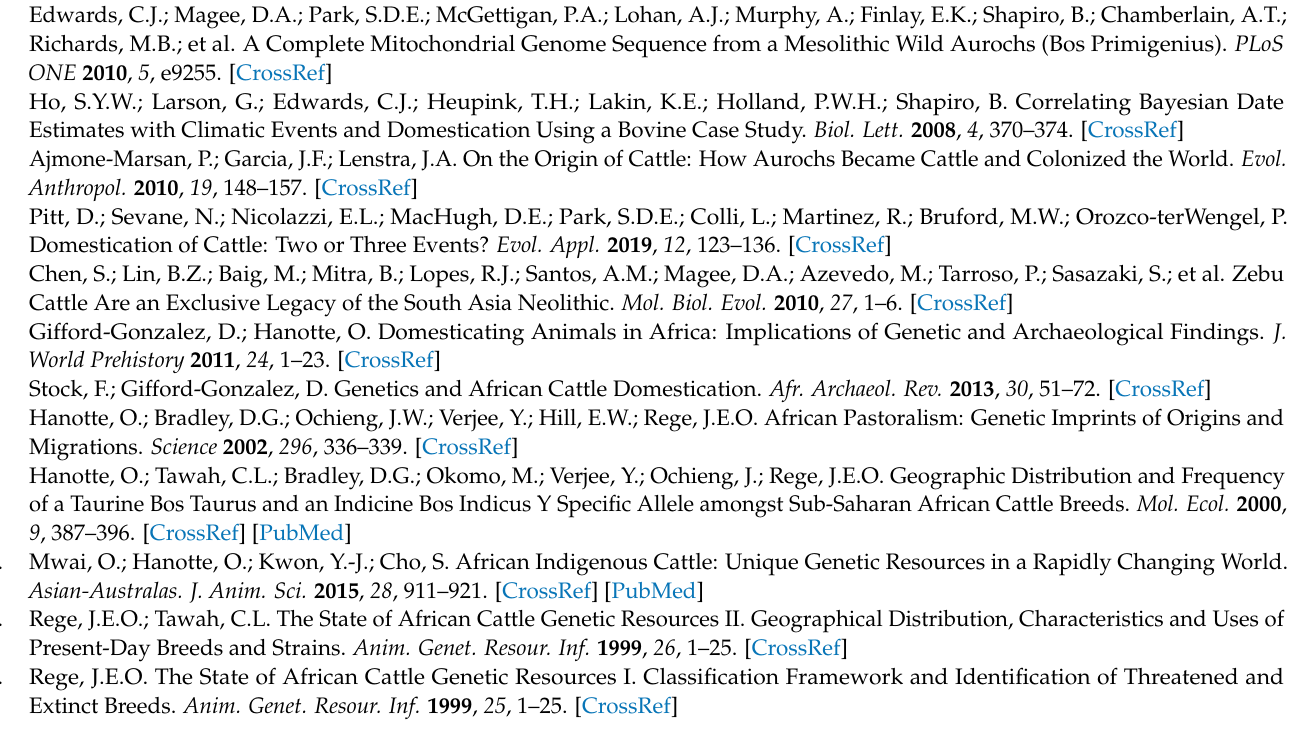
Table S1. Sources, mean sequence coverage, and mapping rate of cattle whole genome sequences (WGS); Table S2. Effective population size in Ethiopian and non-Ethiopian cattle breed groups, 50 to 1000 generations ago; Table S3. Candidate gene regions and annotated genes detected by the pooled heterozygosity scan method for Ethiopian cattle; Table S4. Candidate gene regions and annotated candidate genes detected by the iHS selection scan method for the pooled Ethiopian cattle genomes; Table S5. Candidate gene regions and annotated candidate genes detected by population differentiation; Table S6. Candidate gene regions and annotated candidate genes detected by the XP-CLR scan method; Table S7. GO functional annotation of candidate genes identified by Hp , F ST , iHS , and XP-CLR scan